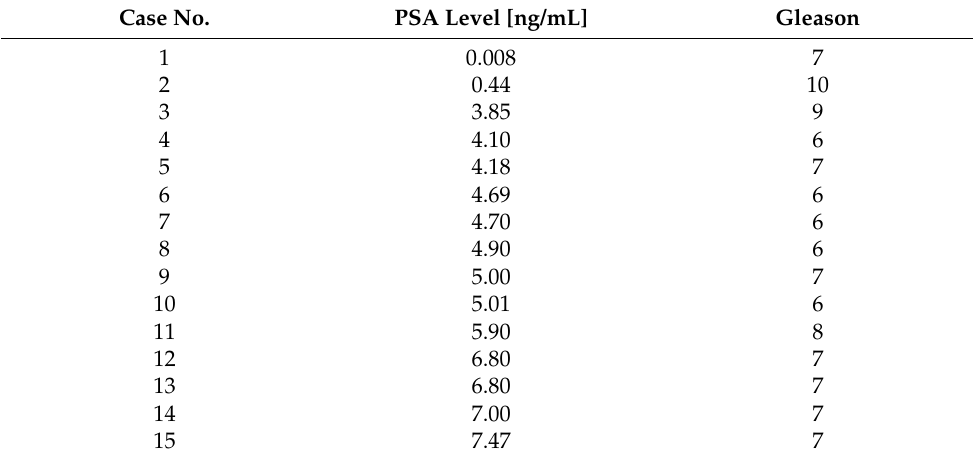
Table 1. Characteristic of samples obtained from prostate cancer patients. Case